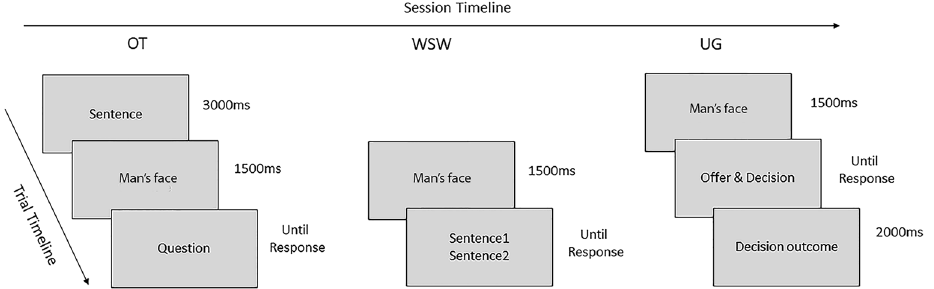
Figure 5. Experimental session and trial timelines. Order of the three tasks performed by the participants, and timeline of the trials for each of them. OT, objectification task; WSW, who says what; UG, ultimatum game task. For the WSW details see Supplementary online materials